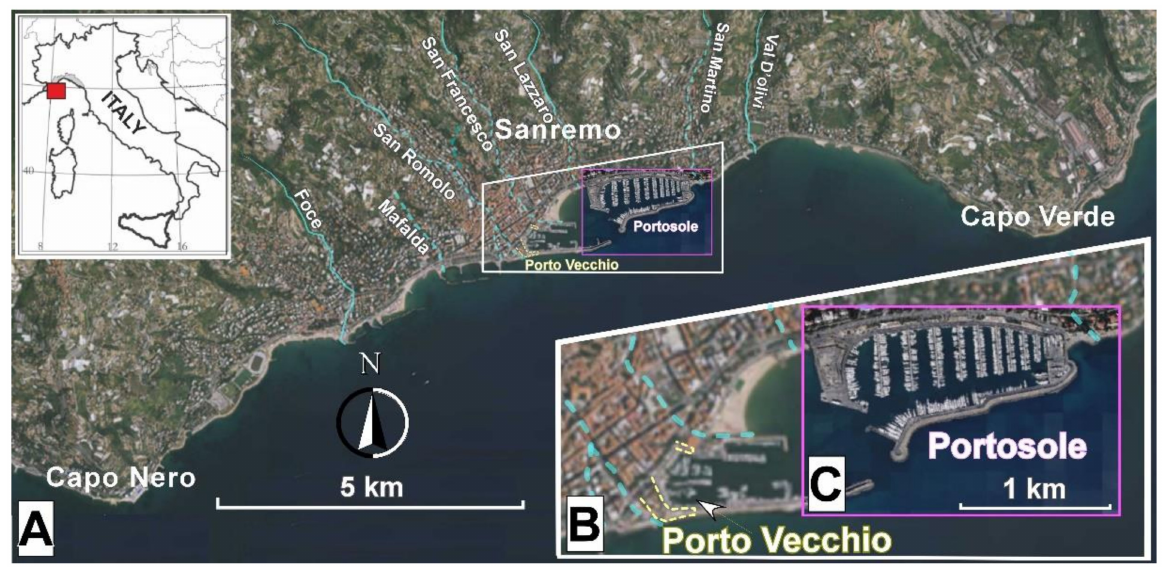
Figure 1. Location of Sanremo: Portosole study area. ( A ) The orthophoto of the Liguria Region (2016) shows how the narrow coastal plain of Sanremo and the course of the main streams crossing it (light blue dotted and continuous lines) are totally occupied by urban settlements. The zoom ( B ) shows the area of the Porto Antico and its ancient piers (dotted yellow line) and the Portosole area, where the morpho-bathymetric surveys were realized ( C